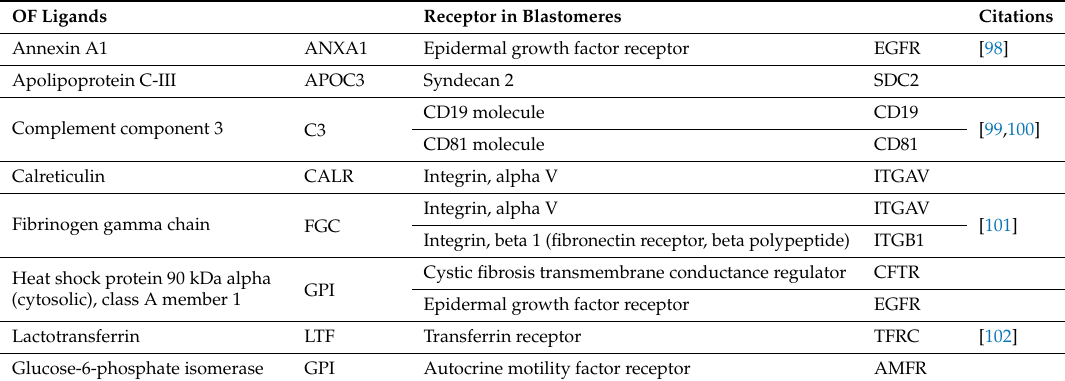
Table 2. Common protein-ligand interactions in di ff erent